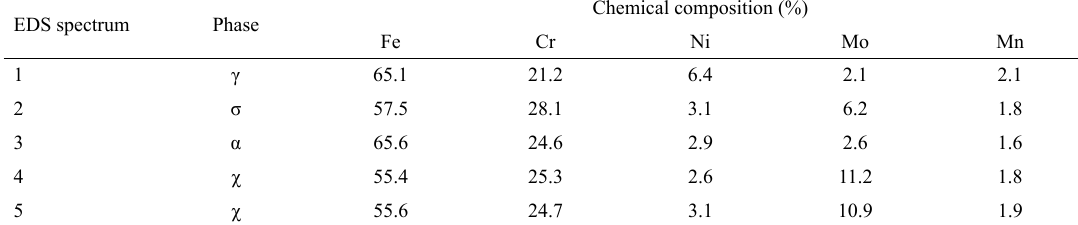
Table 2. Chemical compositions of the γ, α, σ, and χ phases quantified by EDS. EDS spectrum